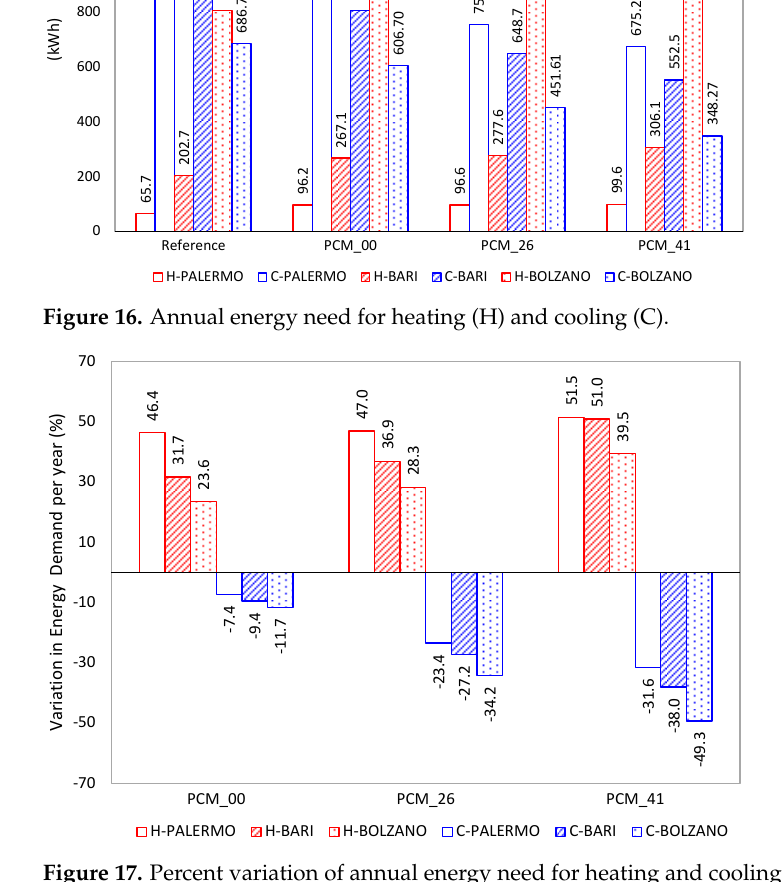
Figure 17. Percent variation of annual energy need for heating and cooling respect to Reference.